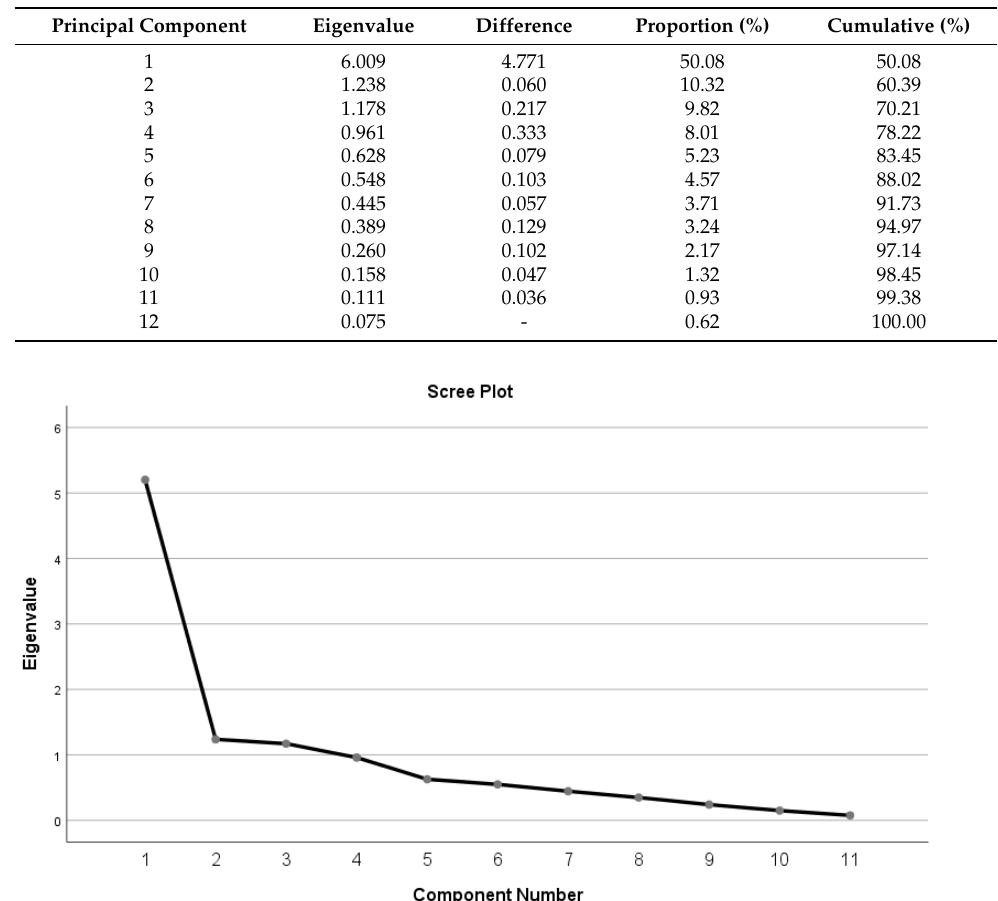
Table 5. Eigenvalues of the correlation matrix.